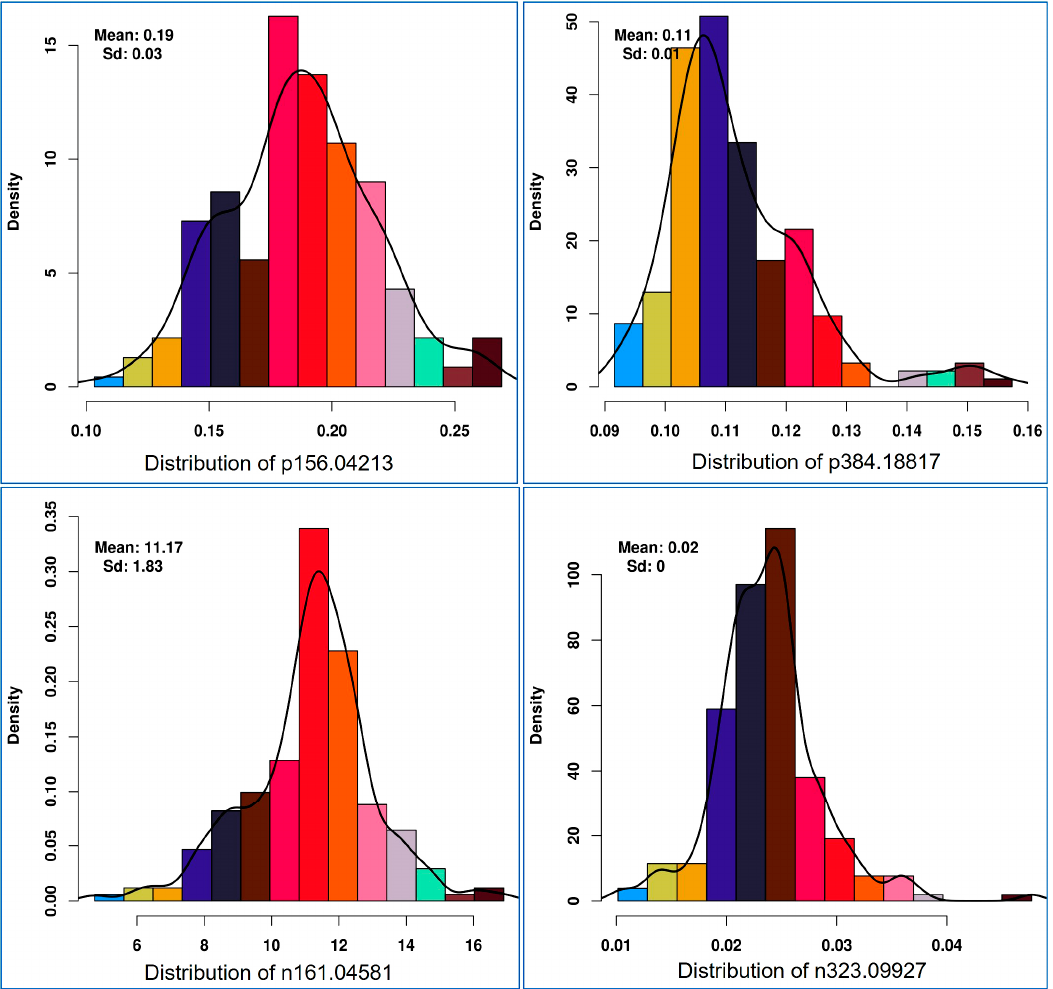
Figure 3. Histogram distribution pattern for selective mass features (p156.04213-in anthocyanin/lipid metabolism, p384.18817-vitamins metabolism, n161.04581-vitamins/starch metabolism, n323.09927-starch and sucrose metabolism) used for mGWAS (metabolic genome-wide association analysis).